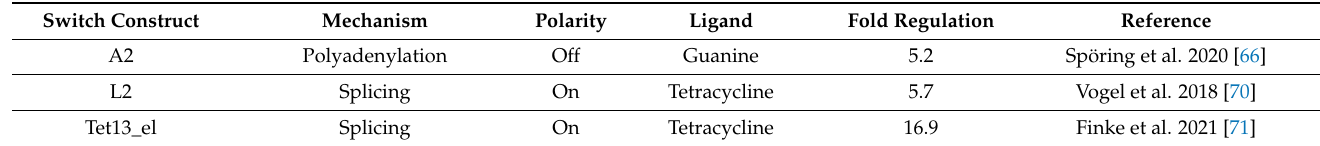
Figure 5. Regulation of CRISPR-Cas Single-Guide RNA Function. Single-guide RNAs (sgRNAs) are fusions of the multiple naturally-occurring gRNAs required for Cas protein targeting and activa- tion [174]. sgRNAs contain a complementary region for targeting (red), along with several stem-loops onto which aptamers may be grafted to control folding (blue, orange). In the unbound state, sgRNAs are functional and can mediate mRNA degradation by Cas proteins (pink). Aptamer binding disrupts gRNA structure, blocking recruitment to Cas proteins and preventing mRNA cleavage. sgRNAs which are activated by aptamer binding have also been developed for use as off-switches [186–188]. Table 1. Performance of Small Molecule-Regulated Riboswitches in Mammalian